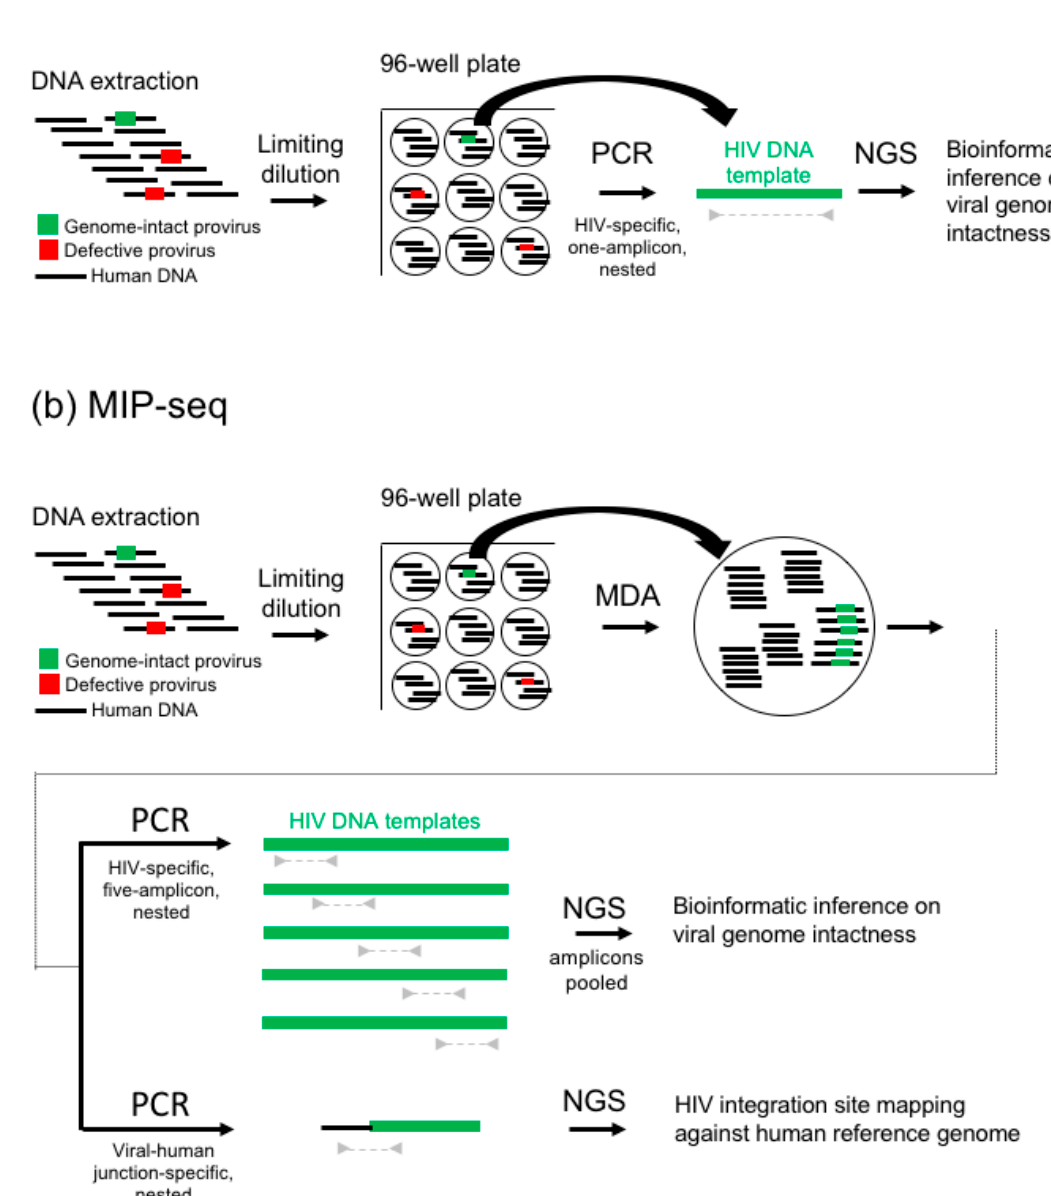
Figure 1. FLIP-seq and MIP-seq workflow. ( a ) FLIP-seq begins with DNA extraction (further discussed in Section 2), followed by limiting dilution to a single HIV-DNA template per subsequent PCR reaction (Section 3), near-full-genome single-amplicon HIV-DNA PCR amplification (Section 4), and finally next-generation deep sequencing (NGS) and bioinformatic inference on viral-genome intactness (Section 5). ( b ) Similar to FLIP-seq, MIP-seq begins with DNA extraction (Sec- tion 2), followed by limiting dilution to achieve single HIV-DNA template per subsequent reaction (Section 3), then mul- tiple displacement amplification (MDA) by random primers. Resulting reaction is split for near-full-genome five-overlap- ping-amplicon HIV-DNA PCR amplification and viral-human junction amplification (Section 4), then subjected to NGS and bioinformatics inference on viral-genome intactness and mapping of viral-human DNA junctions against the human reference genome (Section 5). Note that MIP-seq would not yield full-length sequences of defective viral genomes that do not contain any of the primer binding sites targeted by the 20 primers used in the five-amplicon nested-PCR approach and was designed specifically to capture near-full-length HIV DNA that are approximately >8000 base pairs in length. A single- amplicon, near-full-genome PCR approach was not used in MIP-seq because it was markedly less sensitive due to the average amplification product lengths at the MDA step.